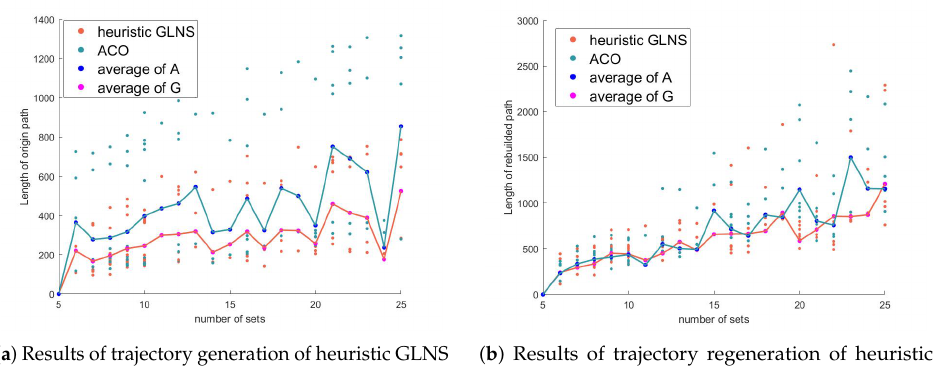
Figure 22. Outputs of 100 runs are scattered, and the average values are illustrated as lines. Generally speaking, heuristic GLNS + KMEANS + KDtree performed better than a common TSP solver.